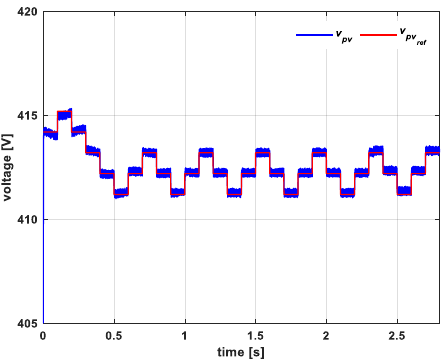
Figure 5. PV voltage (blue line) vs. maximum power point tracking (MPPT) reference voltage (red line).